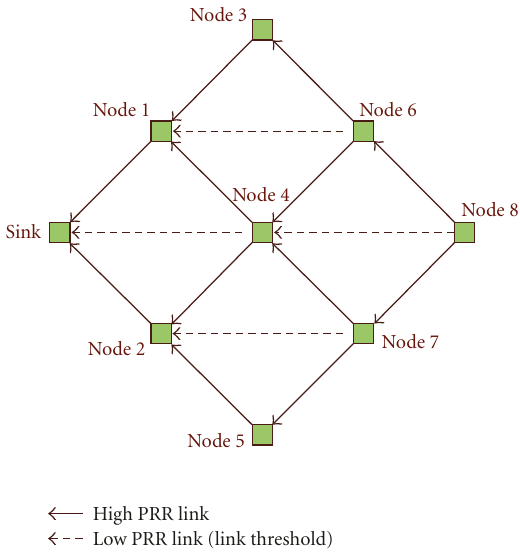
Figure 14: The topology of an exemplary